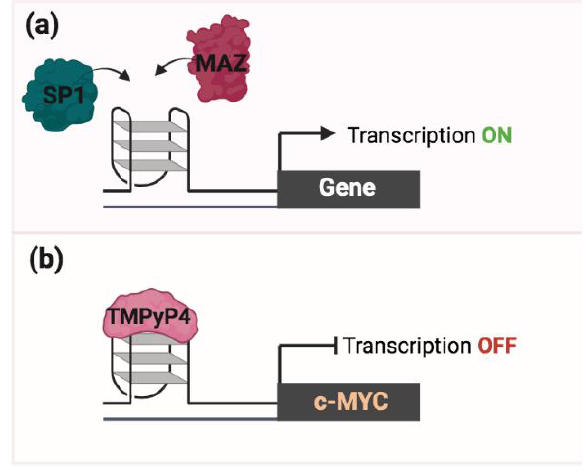
Figure 2. Epigenetic role of G4. ( a ) G4s in the promoter regions of specific genes promote the recruitment of specific TF (SP1 and MAZ) to regulate their expression. ( b ) Stabilization of the G4 structure by TMPyP4, within the MYC promoter, causes a roadblock to MYC transcription.